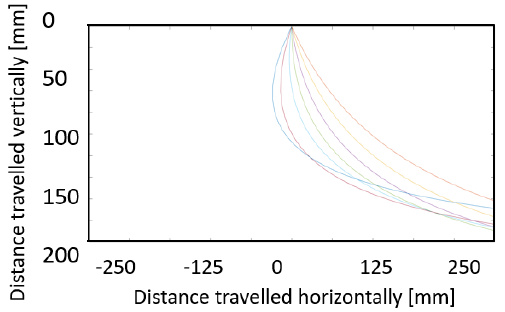
Fig. 10. Particle tracks by analytical code for 16 m/s